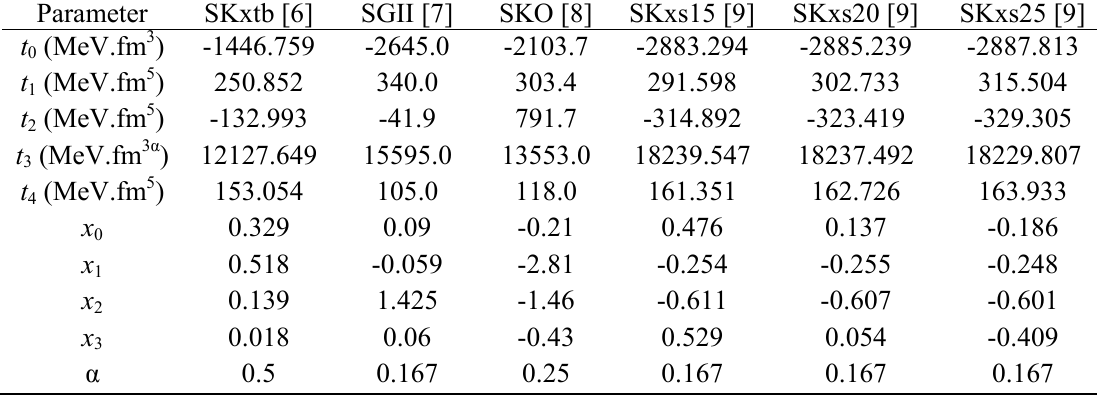
Table 1: The parameters of Skyrme force used in the present calculations.